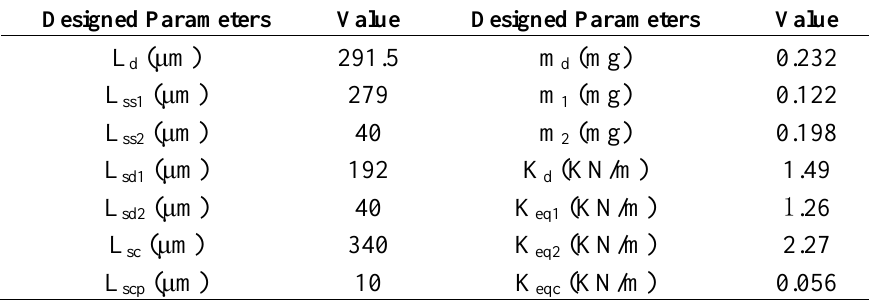
Table 1. Key parameters of the designed